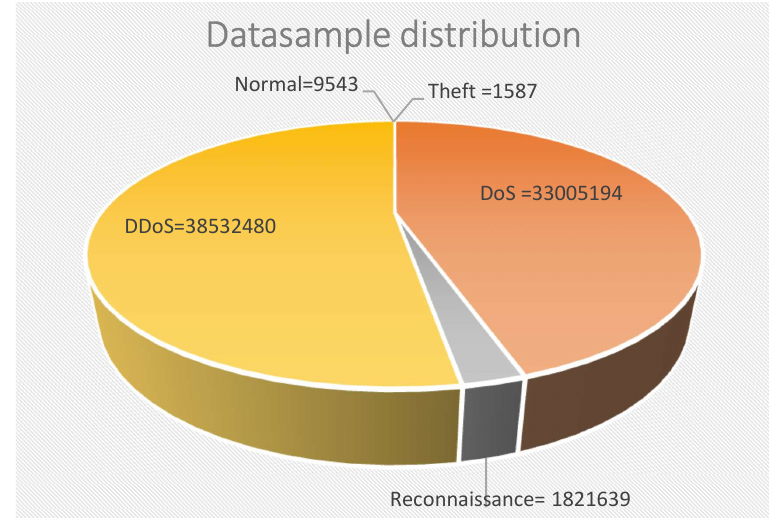
Figure 3. Datasample class